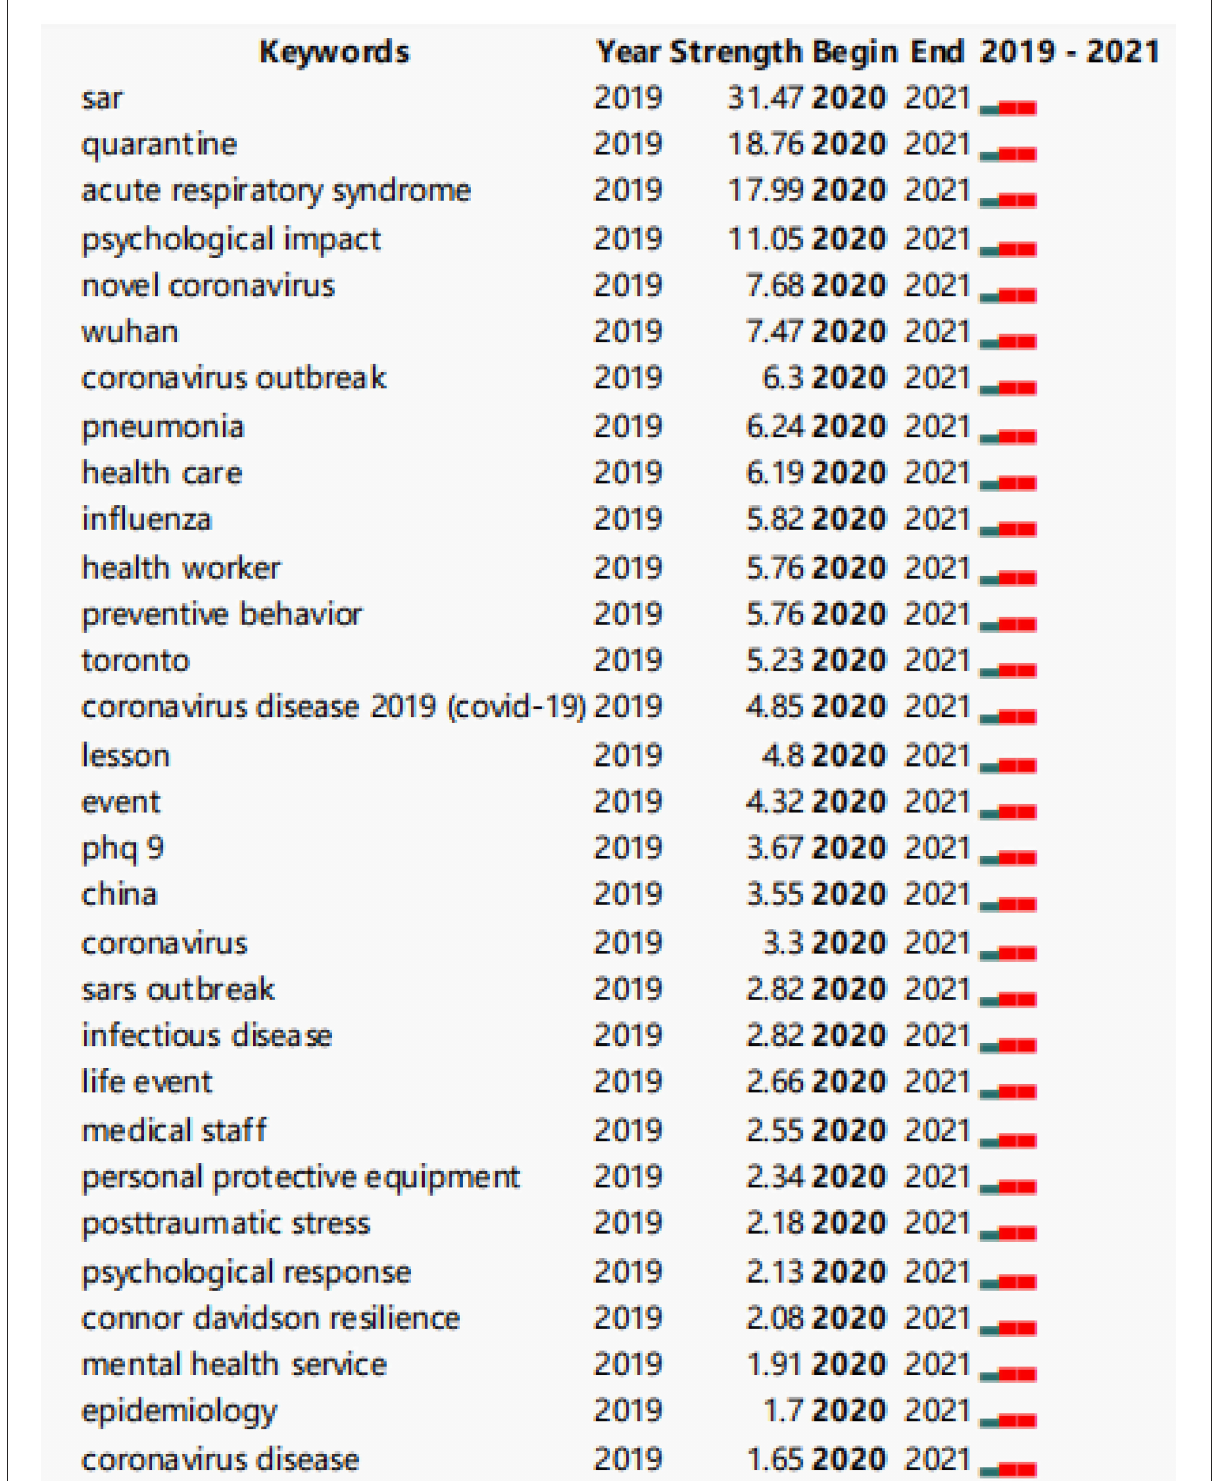
FIGURE7 Top 30 keywords with strongest citation